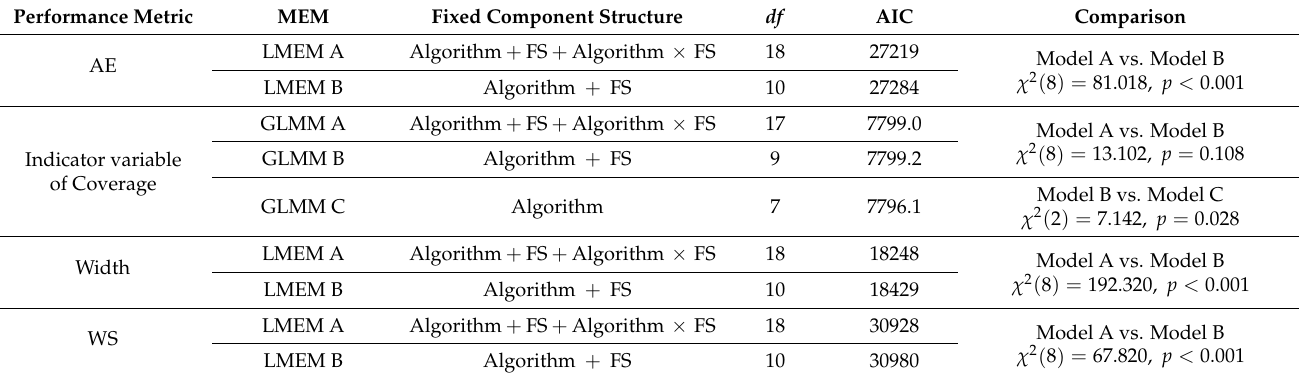
Figure 5. Boxplots of AE distributions (log-transformed scale) for each model (combination of algorithm and FSM). Table 6. Results of mixed effects models on performance metrics.